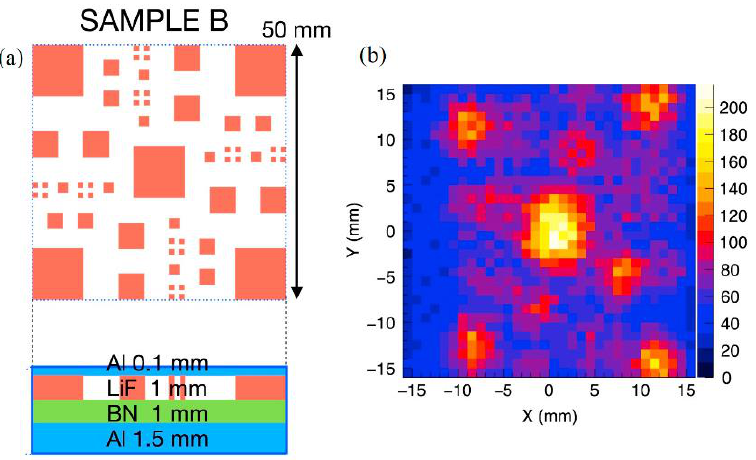
Figure 13. ( a ) Scheme of the sample; ( b ) position of the fluorine in the sample, within the range from 27 keV to 35 keV. Originally published in JPS Conf. Proc. 21, 011044 (2018). Reprinted with permission from Ref. [54] © 2018 The Author(s) of Ref. [54].